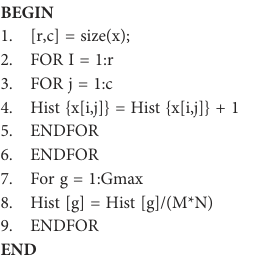
algorithm based on the histogram equalization.